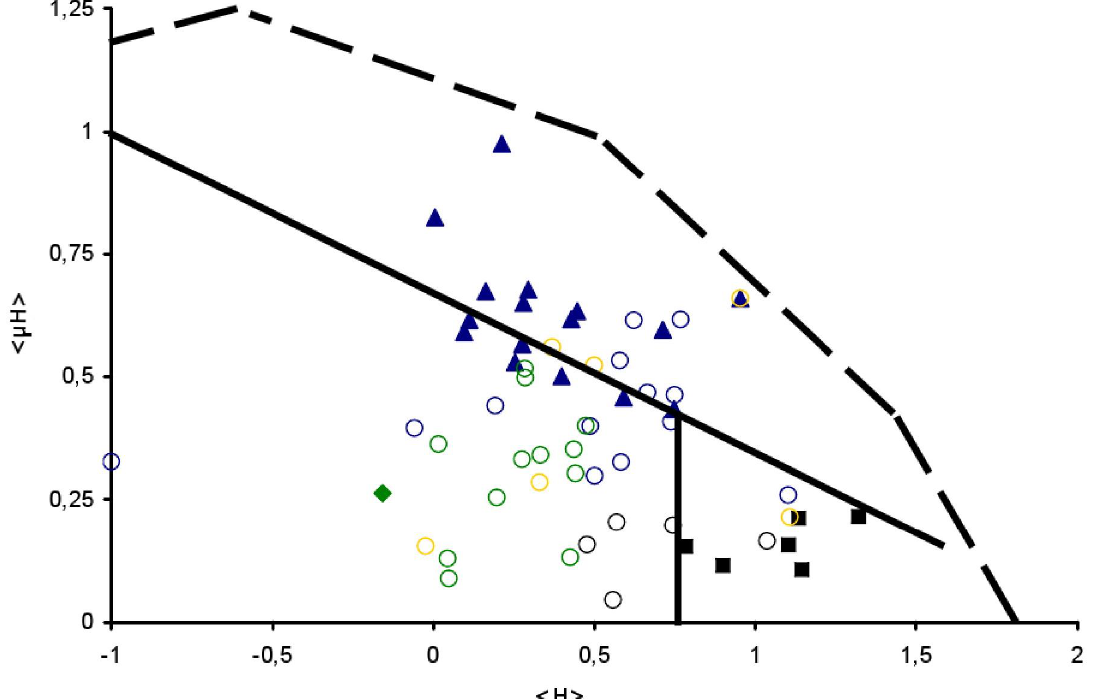
Figure 2. Eisenberg plot of a number of successfully identified proteins and peptides in which Surface seeking (▲), Globular (♦) and TransMembrane (■) segments are depicted, see Table 1 for details. Examples of signal peptides (SP) (circles, black), lipid-binding peptides (LBP) (circles, blue), amphitropics (circles, green) and others (circles, orange) are depicted, see Table 2 for